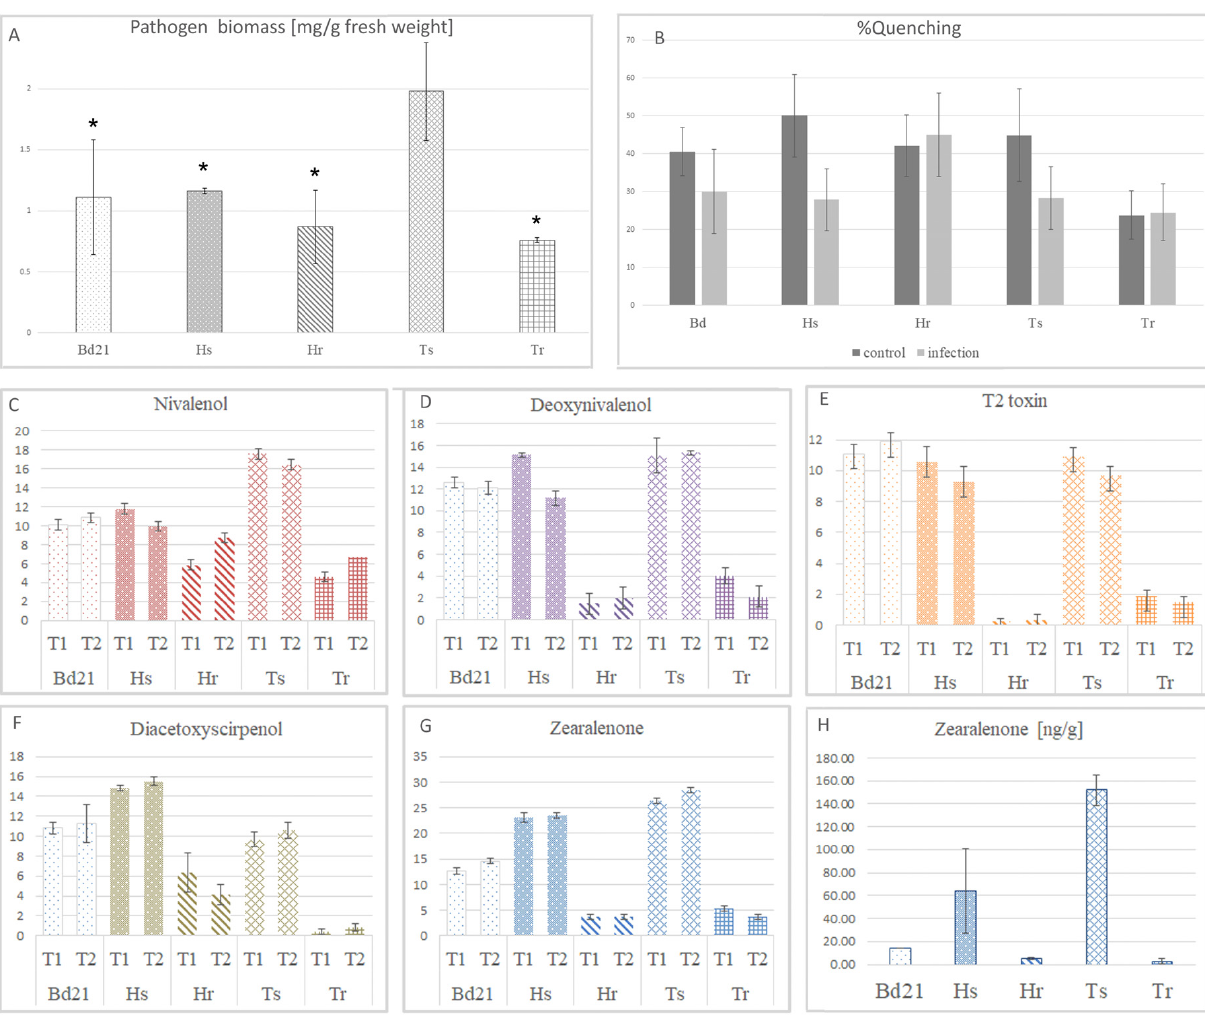
Figure 1. Progress of pathogenesis in different genotypes of Poaceae measured by ( A ) Fusarium culmorum biomass quantified by real-time qPCR assay. Significant differences between susceptible and resistant plants were filtered by using Student’s t-test: * p -value < 0.05; ( B ) DPPH radical scavenging capacities of the methanolic extracts of plants expressed as nM trolox equivalent (TE) per 100 g of extract; ( C ) LC-MS measurement of nivalenol accumulation at T1 and T2; ( D ) LC-MS measurement of deoxynivalenol accumulation at T1 and T2; ( E ) LC-MS measurement of T2 toxin accumulation at T1 and T2; ( F ) LC-MS measurement of diacetoxyscirpenol accumulation at T1 and T2; ( G ) LC-MS measurement of zearalenone accumulation at T1 and T2; ( H ) quantitative measurement of zearalenone accumulation (ng/g dry weight) in infected plants at T2; in ( C – H ), results for control plants were skipped as the level of mycotoxin was close to or under the detection limit; symbol “Bd” is for Brachypodium distachyon Bd21 line, ”Hs” is for Hordeum vulgare FHB—susceptible genotype, “Hr” is for Hordeum vulgare FHB—resistant genotype, “Ts” is for Triticum aestivum FHB—susceptible genotype and “Tr” is for Triticum aestivum FHB—resistant genotype.